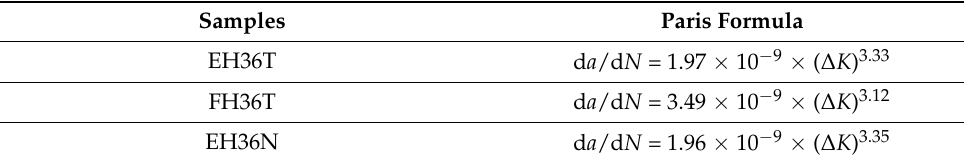
Table 6. Paris formulas of the offshore structural